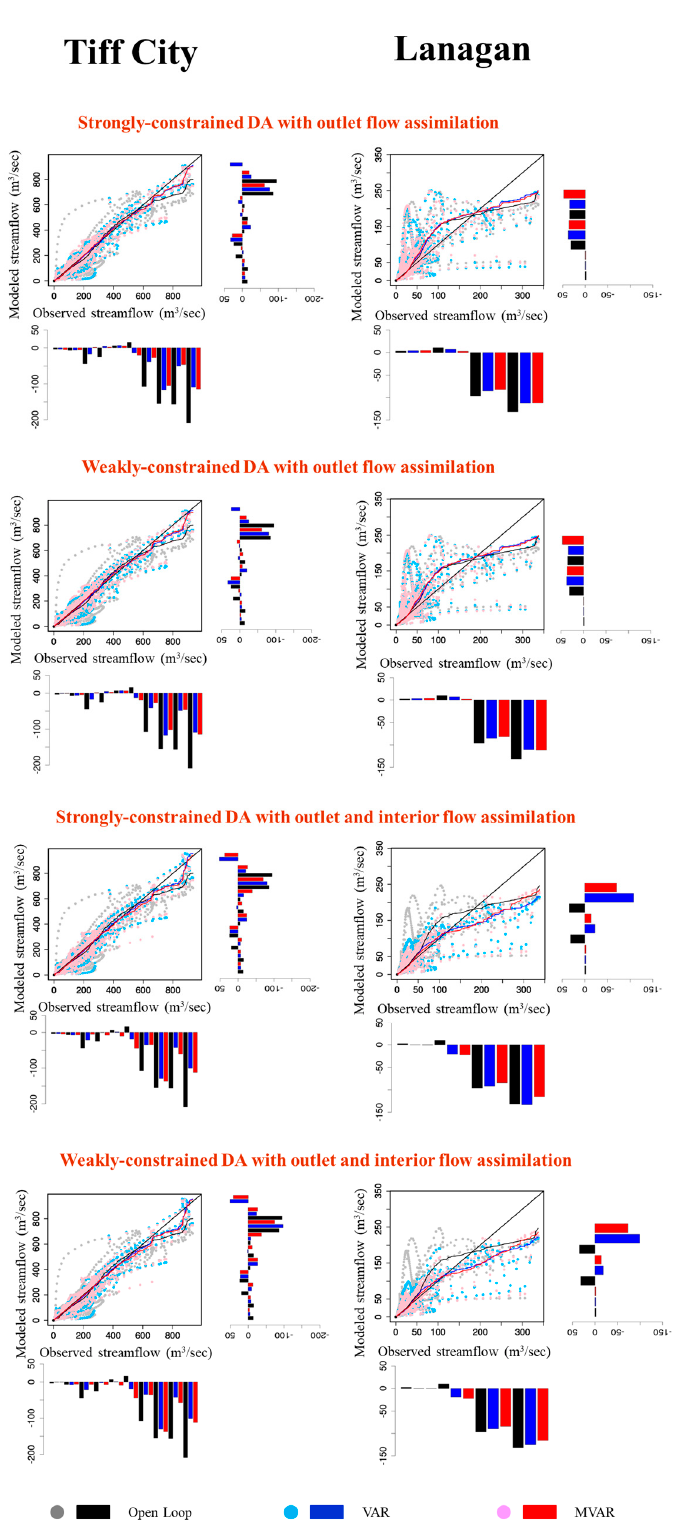
Figure 10. Scatter plots of observed and simulated flow from the open loop, VAR, and MVAR at Tiff City and Lanagan. Type-I (Equation (19)) and Type–II (Equation (20)) conditional biases in streamflow are shown as bar plots on the right-hand side or at the bottom, respectively, of the scatter plot.